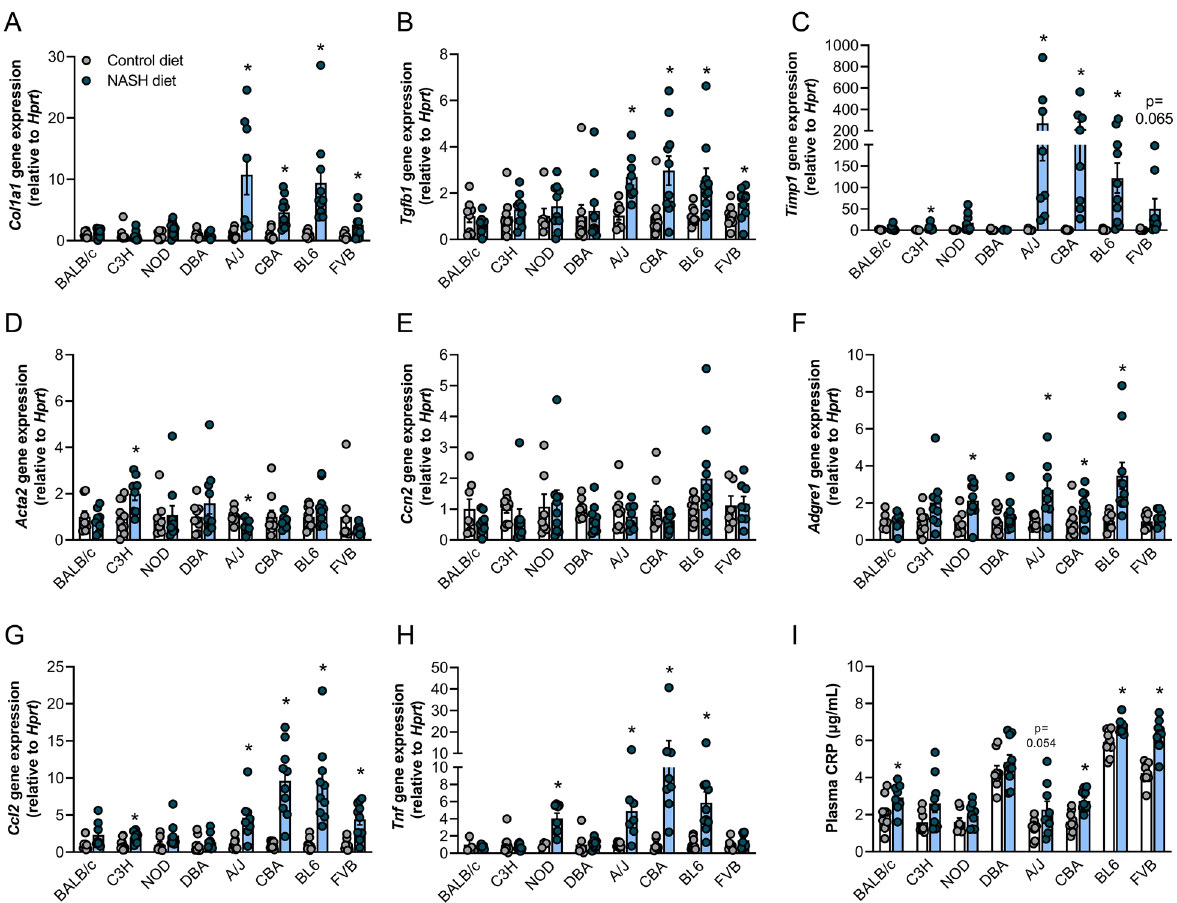
Figure 2. Analysis of genes encoding profibrotic and proinflammatory proteins in the liver. mRNA expression was assessed in the livers of Control (brown) and western diet-fed (blue) A/J, BALB/c, C3H/HeJ, C57BL/6 J, CBA/CaH, DBA/2 J, FVB/N and NOD/ShiLtJ mice, including ( A ) α-1 type I collagen ( Col1a1 ) (n = 8–10/ group), ( B ) transforming-growth factor-1 ( Tgfb1 ) (n = 7–10/group), ( C ) tissue inhibitor of metalloproteinases 1 ( Timp1 ) (n = 6–10/group), ( D ) α-2 actin ( Acta2 ) (n = 8–10/group), ( E ) connective tissue growth factor ( Ccn2/ Ctgf ) (n = 6–10/group), ( F ) adhesion G protein-coupled receptor E1 ( Adgre1 / F4/80 ) (n = 8–10/group), ( G ) chemokine (C–C motif) ligand 2 ( Ccl2 / Mcp1 ) (n = 7–10/group) and ( H ) tumour necrosis factor α ( Tnf ) (n = 6–10/group, n = 3 Balb/c and NOD Chow (not detected in other mice for these strains)). ( I ) Plasma C-reactive protein (CRP) (n = 8–10/group), with mouse strains in all graphs sorted by increasing prevalence of NASH and liver fibrosis (as assessed by histopathological grading). Data are means ± SEM, *p < 0.05 vs. respective controls, as assessed by two-way unpaired